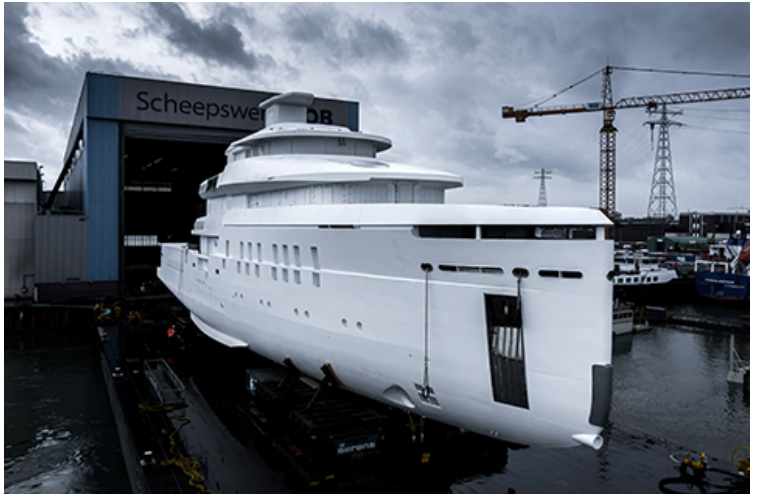
Figure 6. Vertical bow